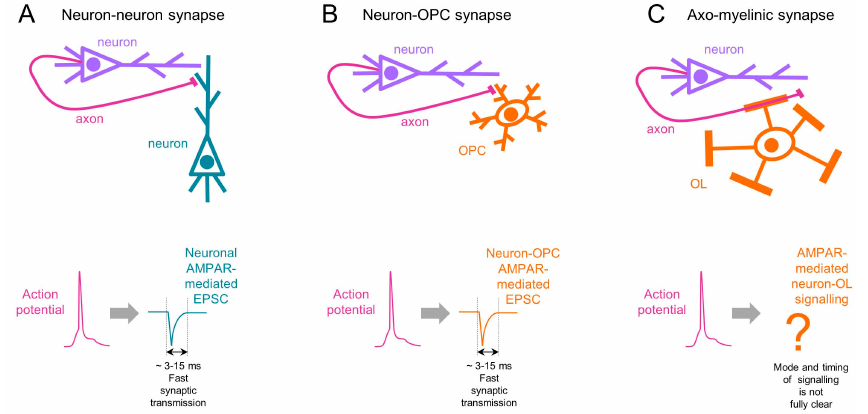
Figure 3. Timing of neurotransmission at ( A ) neuronal synapses, ( B ) neuron–OPC synapses, and ( C ) axo-myelinic synapses. The upper panels are a schematic drawing of the connections between ( A ) two neurons, ( B ) a neuron and an OPC, and ( C ) an axon and an OL. The corresponding lower panels show the action potential in the axons (spike in magenta colour), and the corresponding fast excitatory postsynaptic current (EPSC) at neuronal and neuron–OPC synapses (blue color). The mode of signalling at axo-myelinic synapses is not fully clear, but appears to be slower than at classical synapses.